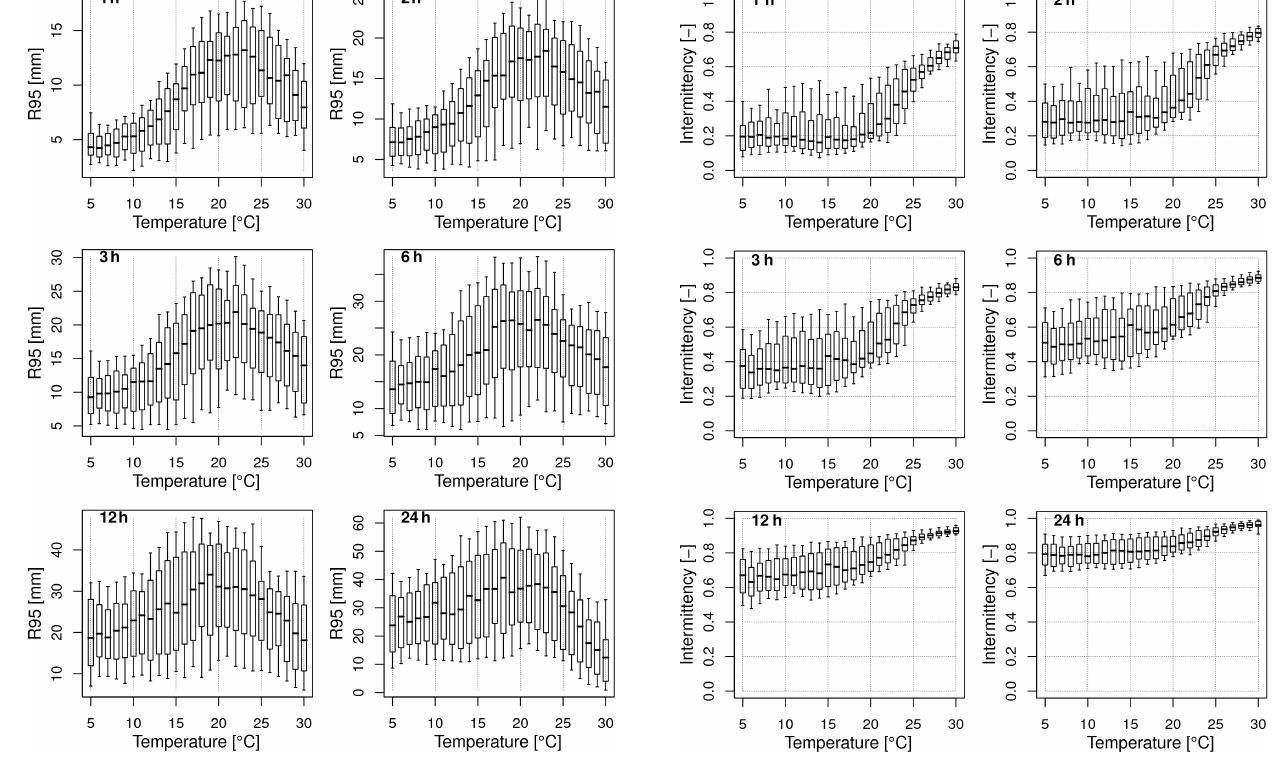
Figure 7. Box plots of internal intermittency vs. temperature for 1, 2, 3, 6, 12 and 24h aggregation timescales.